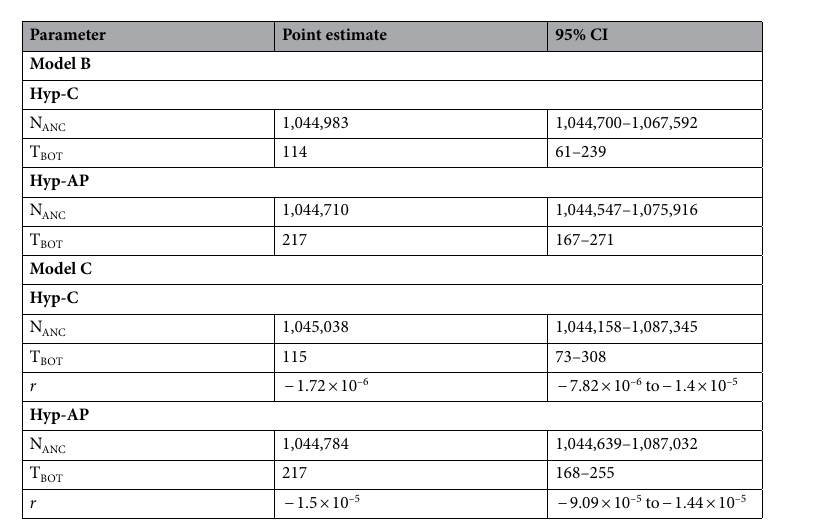
Table 3. Point estimates of demographic history of two invasive Hypogeococcus species and 95% confidence intervals of parameters inferred from coalescent simulations using Fastsimcoal2. Point estimates included parameters for the two models fitting our data, such as timing of effective population size reduction given in number of generations (T BOT ), historical effective population size (N ANC ), and growth rate ( r ). Contemporary effective population size was fixed in the models (Hyp-C, N CUR = 206,750; Hyp-AP, N CUR =